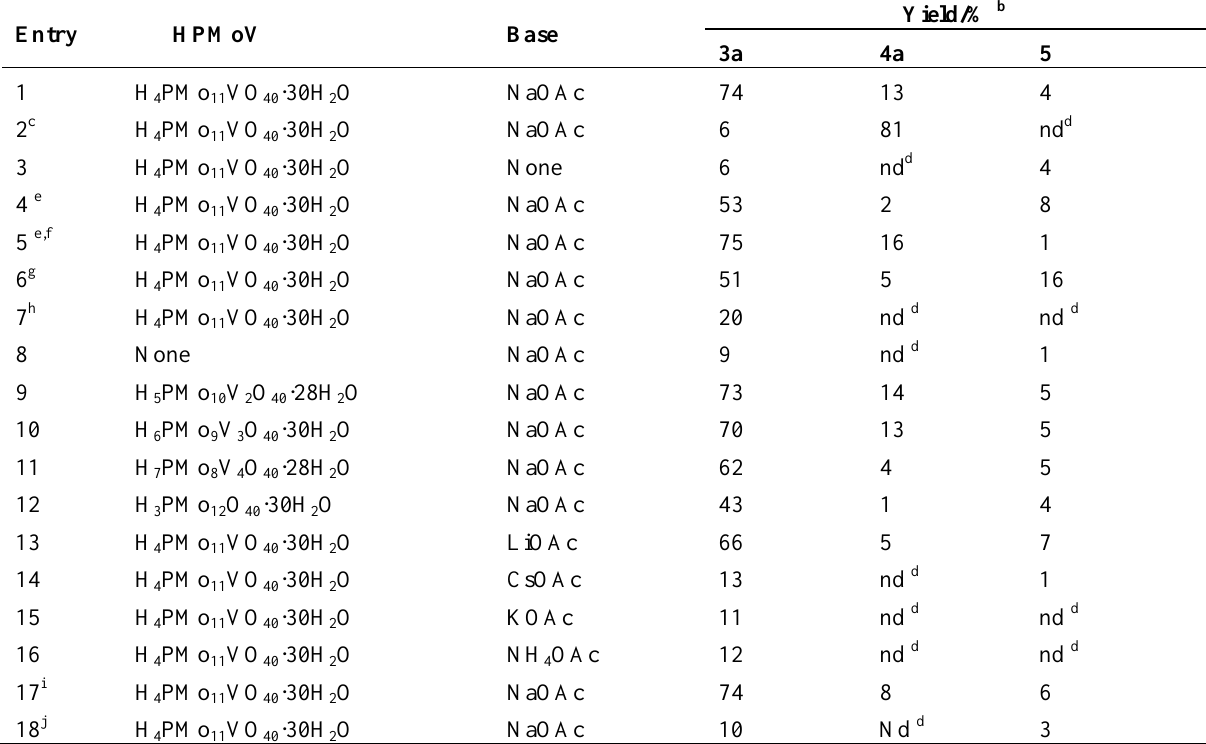
Table 1. Oxidative coupling of benzene ( 1a ) with ethyl acrylate ( 2a ) catalyzed by Pd(II)/HPMoV. a